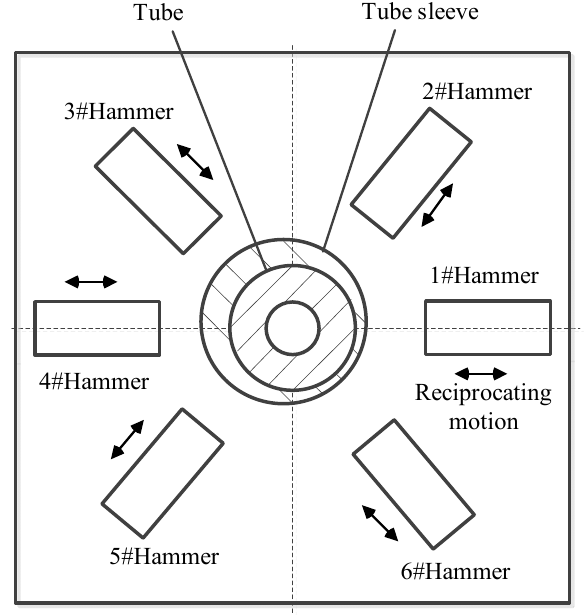
Figure 1. Working principle of pneumatic fatigue impact separation.